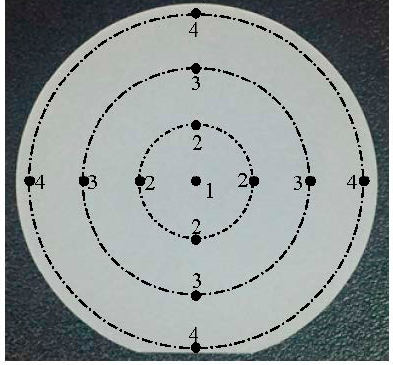
Figure 13. Measurement point position on the sapphire substrate.